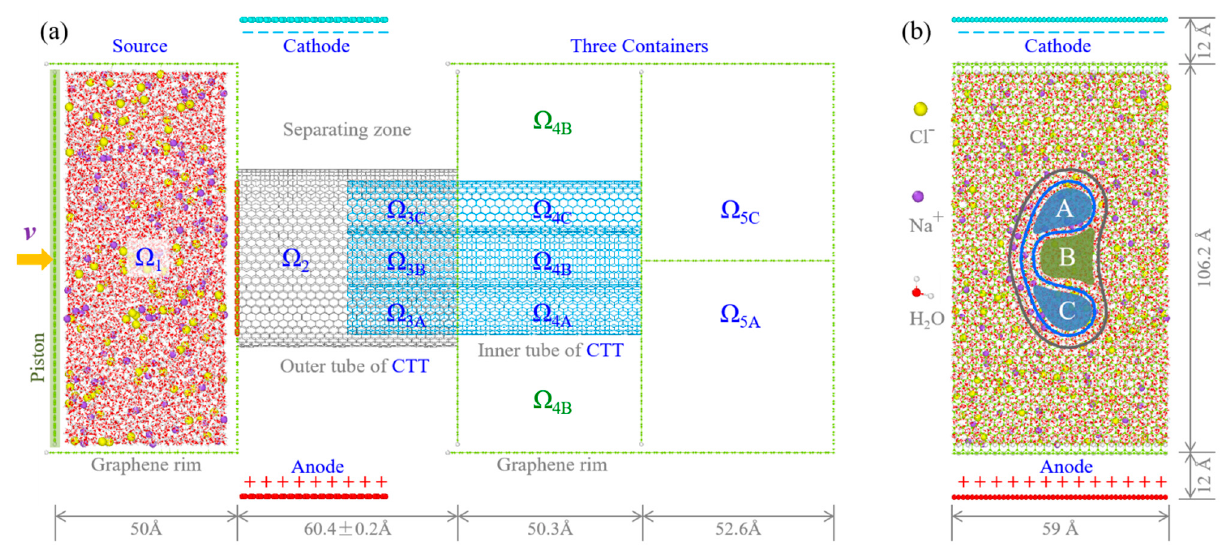
Figure 1. The unit cell of a membrane model for ion separation. ( a ) Side-view and ( b ) axial-view of the system. It has four essential components. First, the source reservoir Ω 1 contains NaCl aqueous solution for separation. A piston at the left side of Ω 1 provides an external pressure on the solution. It moves at a constant speed v = 0.01 Å/ps. Second, three containers ( Ω 4B , Ω 5A , and Ω 5C ) are separated by graphene rims. Third, a concentric-twin-nanotube (CTT) channel connects the source reservoir and the three containers. The final component is the capacitor made from dual-charged graphene ribbons with size of 39 Å × 59 Å. It provides an electric field that covers part of the outer tube of CTT. The overlap of the two tubes in the CTT contains three subchannels, i.e., Ω 3A , Ω 3B , and Ω 3C , for ion separation.